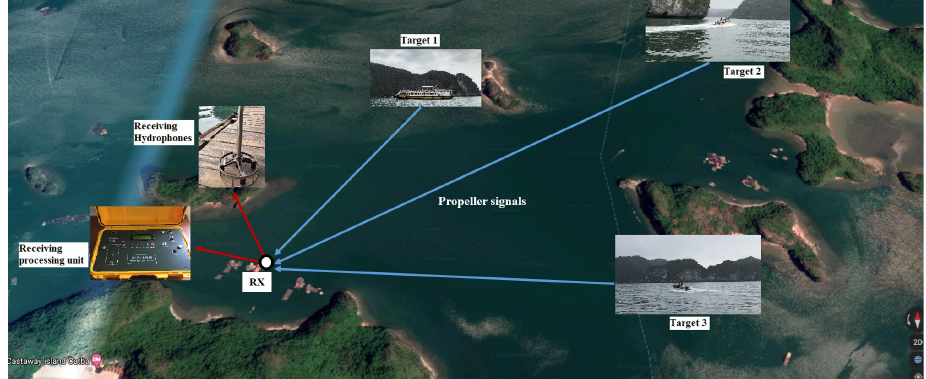
Figure 20. Location of receiver units and some targets on Google